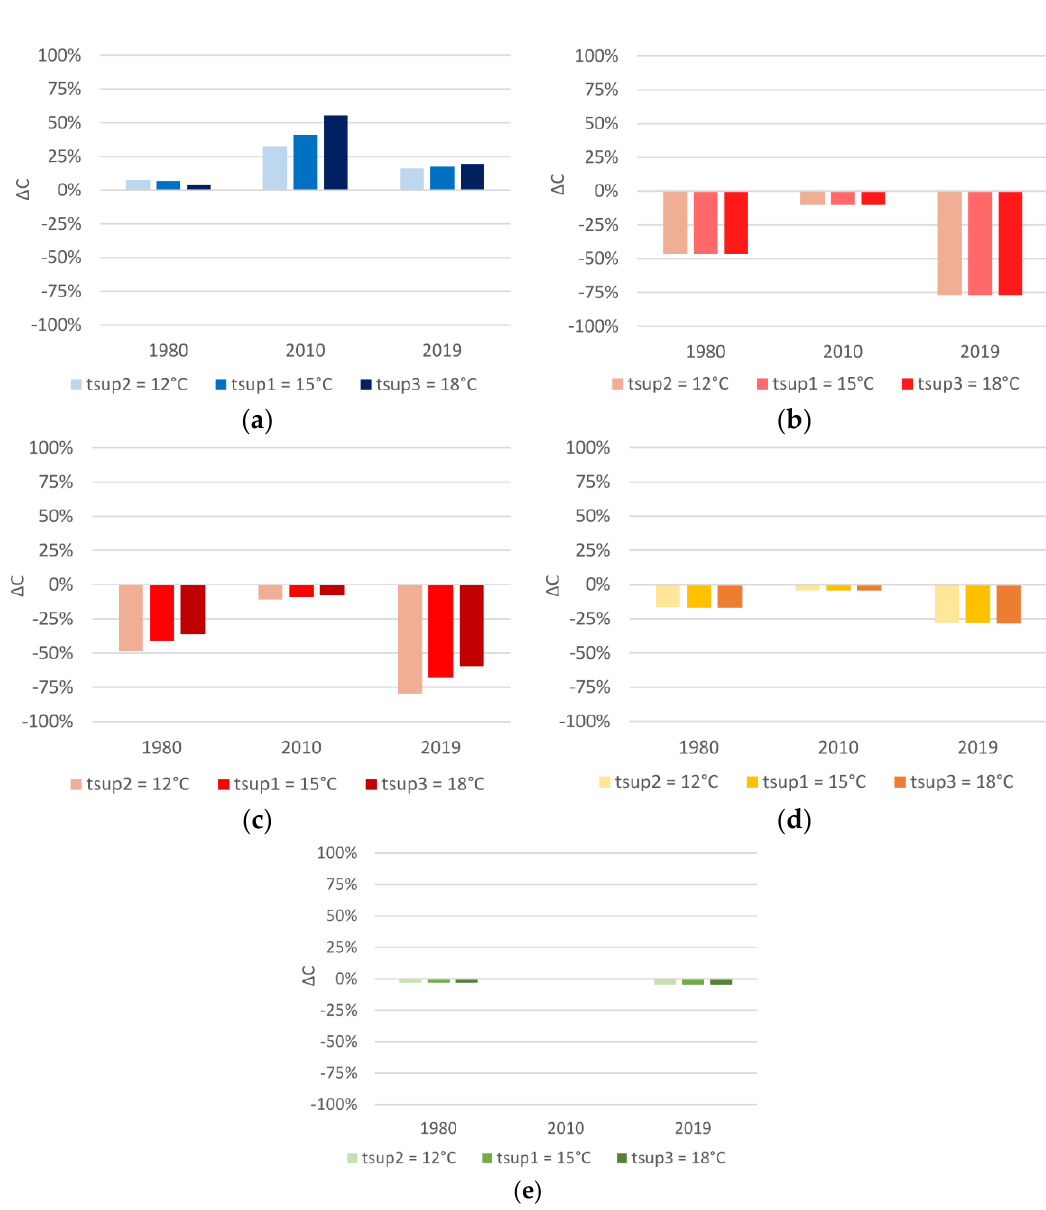
Figure 17. Relative capacity of heat exchangers, compared to 1969: ( a ) cooler, ( b ) preheater, ( c ) heater, ( d ) humidifier, ( e ) and plate heat exchanger.